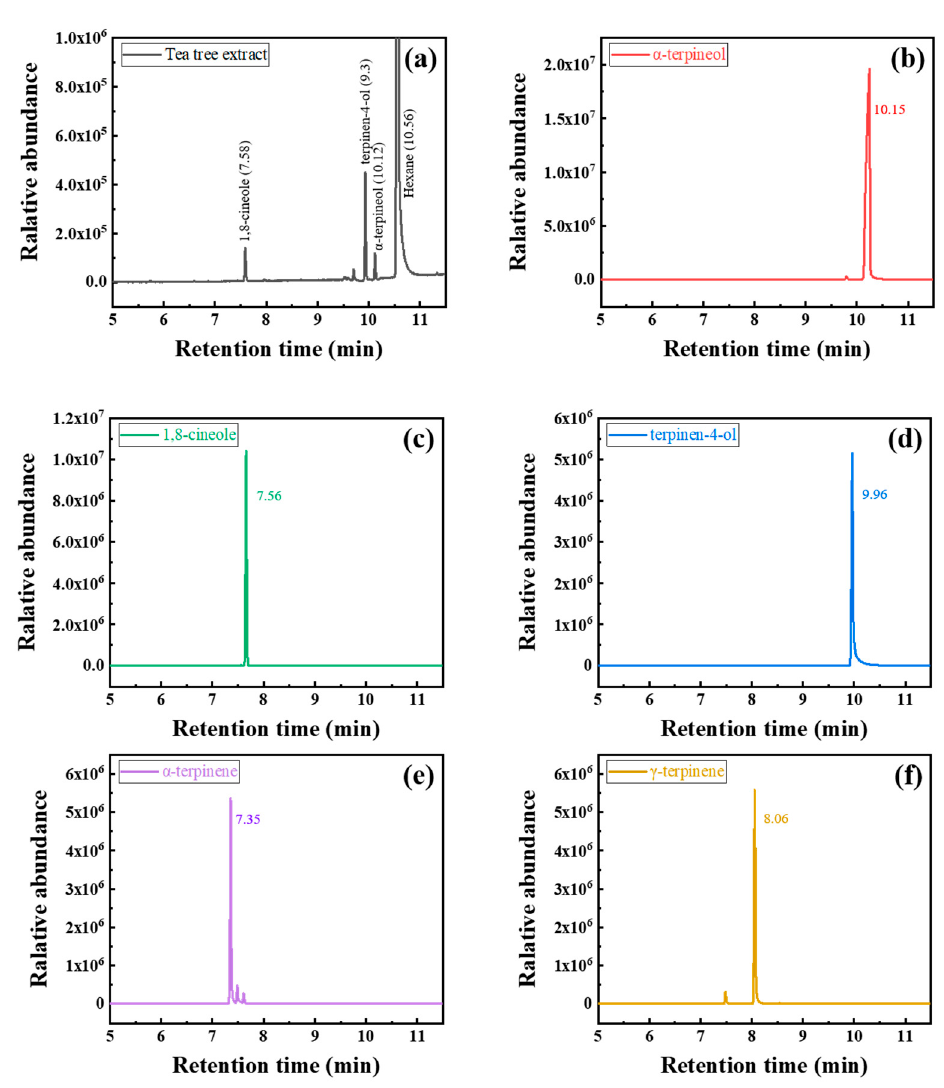
Figure 5. Chromatograms of ( a ) tea tree extract, ( b ) α -terpineol ( c ) 1,8-cineole, ( d ) terpinen-4-ol, ( e ) α –terpinene, and ( f ) γ -terpinene.